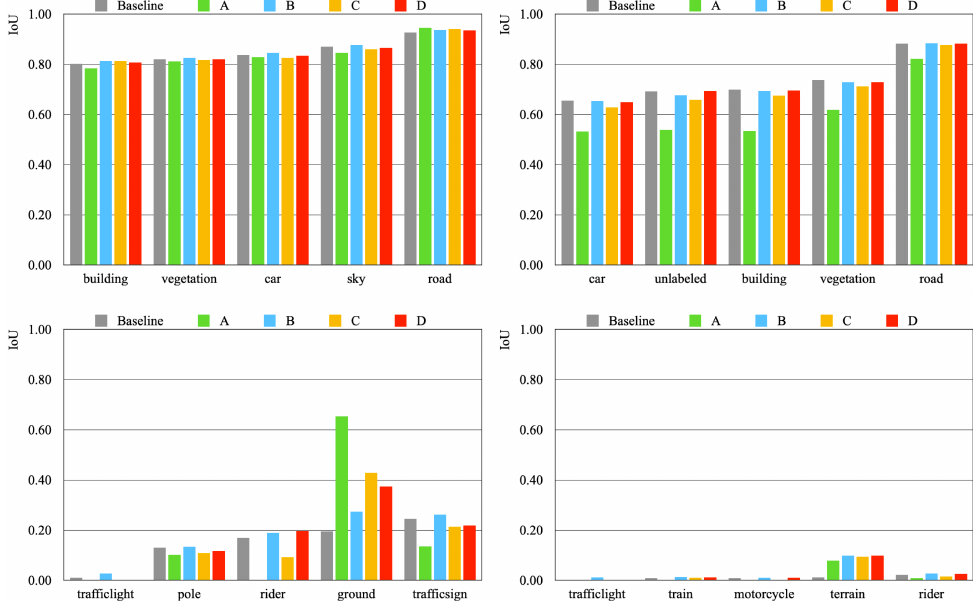
Figure 23. Comparison of IoU scores between the respective classes: upper five class for training subset ( upper left ), upper five class for test subset ( upper right ), lower five class for training subset ( bottom left ), and lower five class for test subset ( bottom right ).